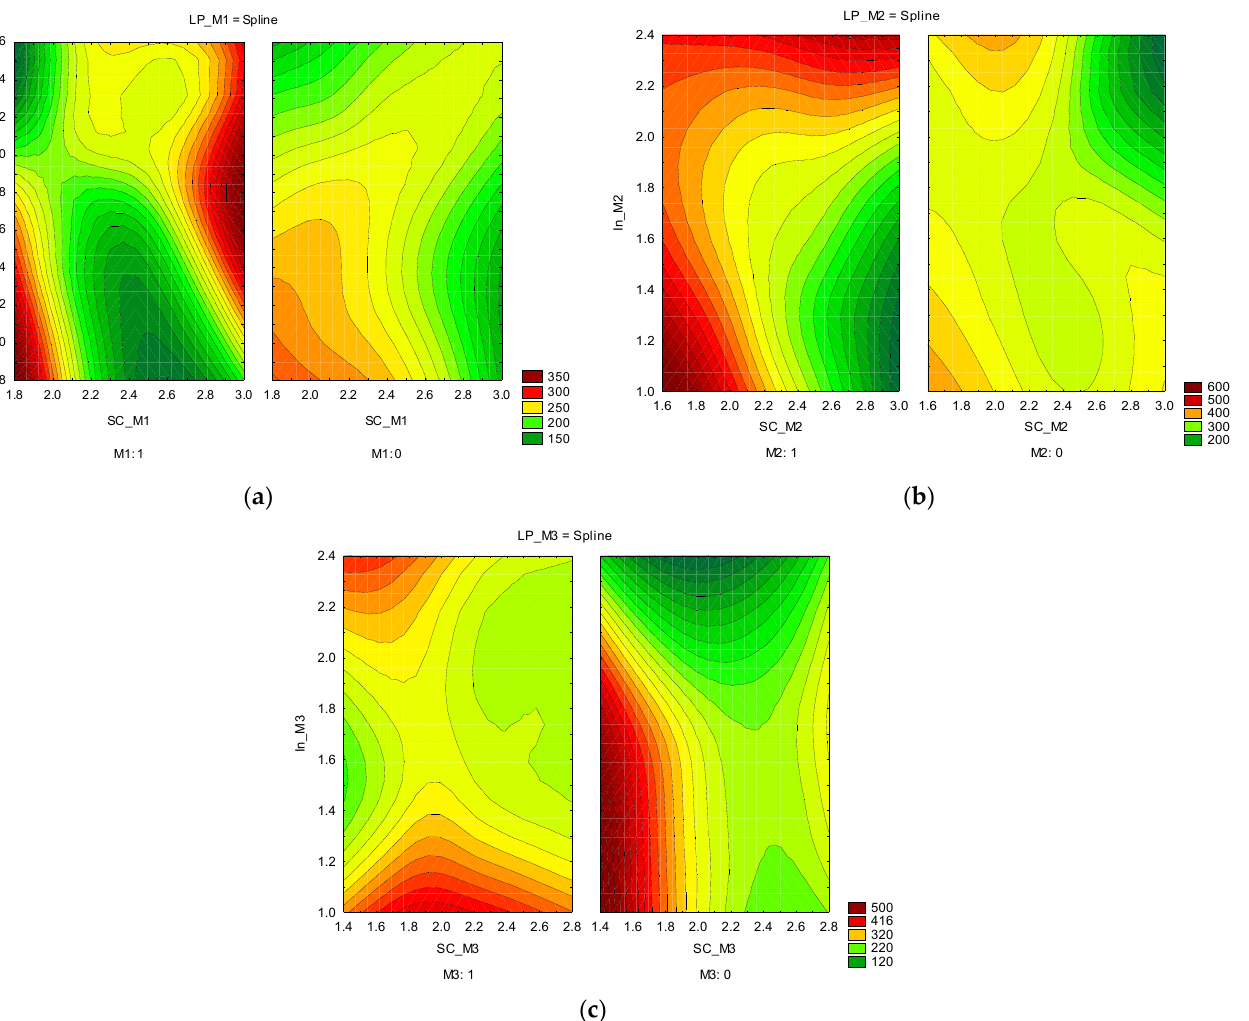
Figure 3. 3d maps of the dependence of labor productivity (LP) on social capital (SC) and innovativeness (In): ( a ) under the conditions of the program M1 implementation, for the treatment group (M1:1) and the control group (M1:0); ( b ) under the conditions of the program M2 implementation, for the treatment group (M2:1) and the control group (M2:0); ( c ) under the conditions of the program M3 implementation, for the treatment group (M3:1) and the control group (M3:0).